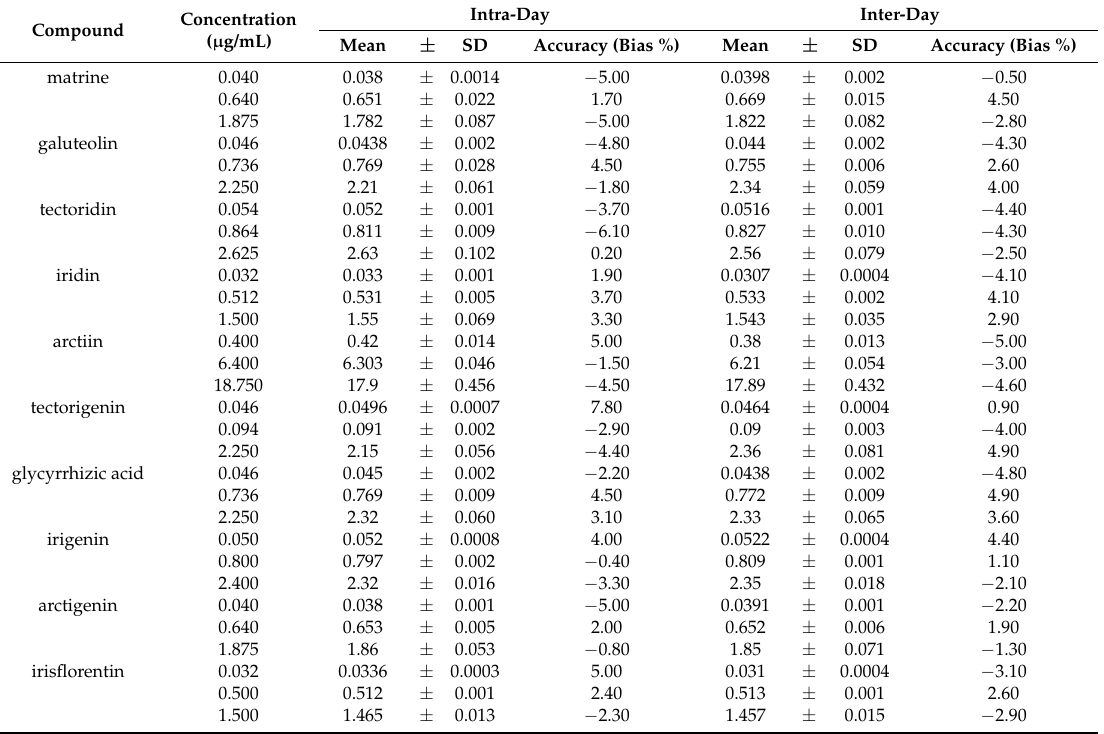
Table 3. Intra- and inter-day precision and accuracy of the ten compounds.